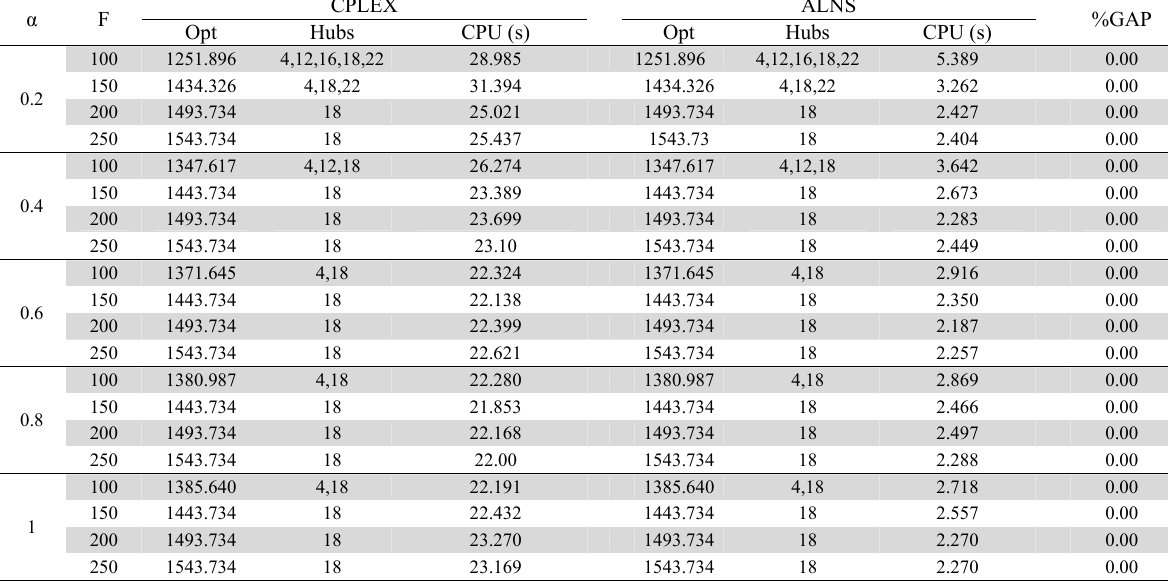
Results for the CAB data set with θ =